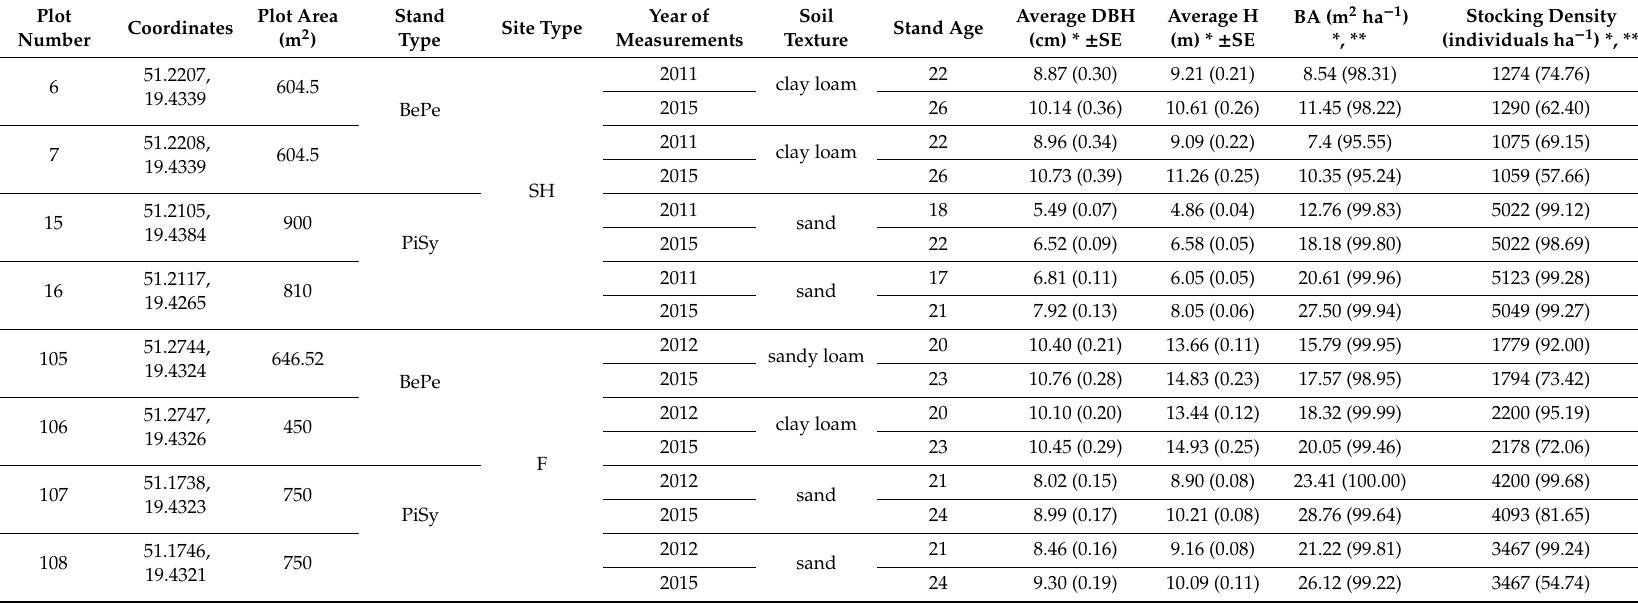
Table A1. Basic characteristics of sample plots. Abbreviations: BePe— Betula pendula ; PiSy— Pinus sylvestris ; SH—spoil heap; F—forest sites; CL—clay loam; S—sand; SL—sandy loam; BA—basal area at breast height; DBH—diameter at breast height; H—tree height; SE—standard